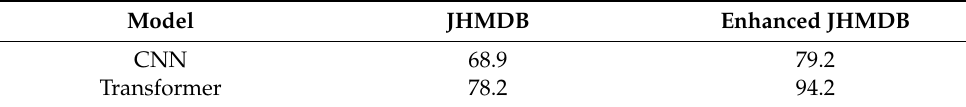
Table 2. Comparison of CNN and transformer model results.